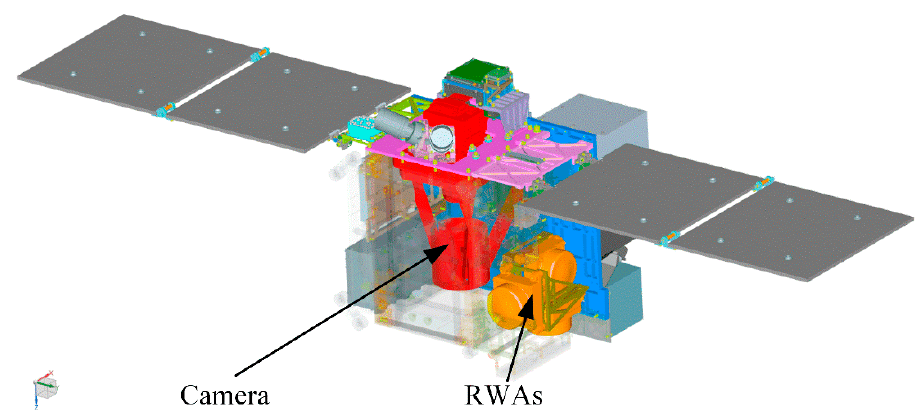
Figure 2. 3D model of the satellite. Table 1. The parameters of the satellite.